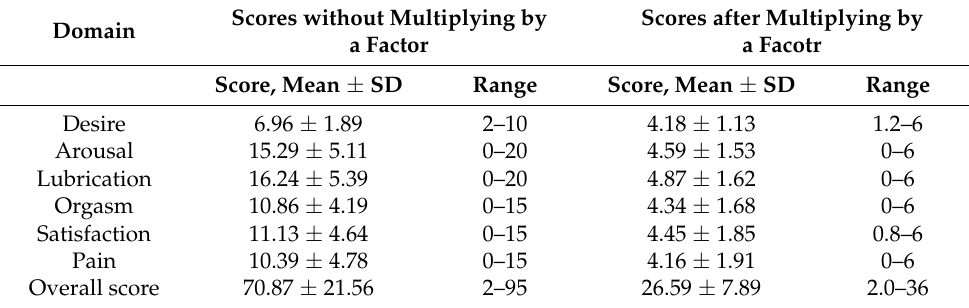
Table 3. Results of the Female Sexual Functioning Index.